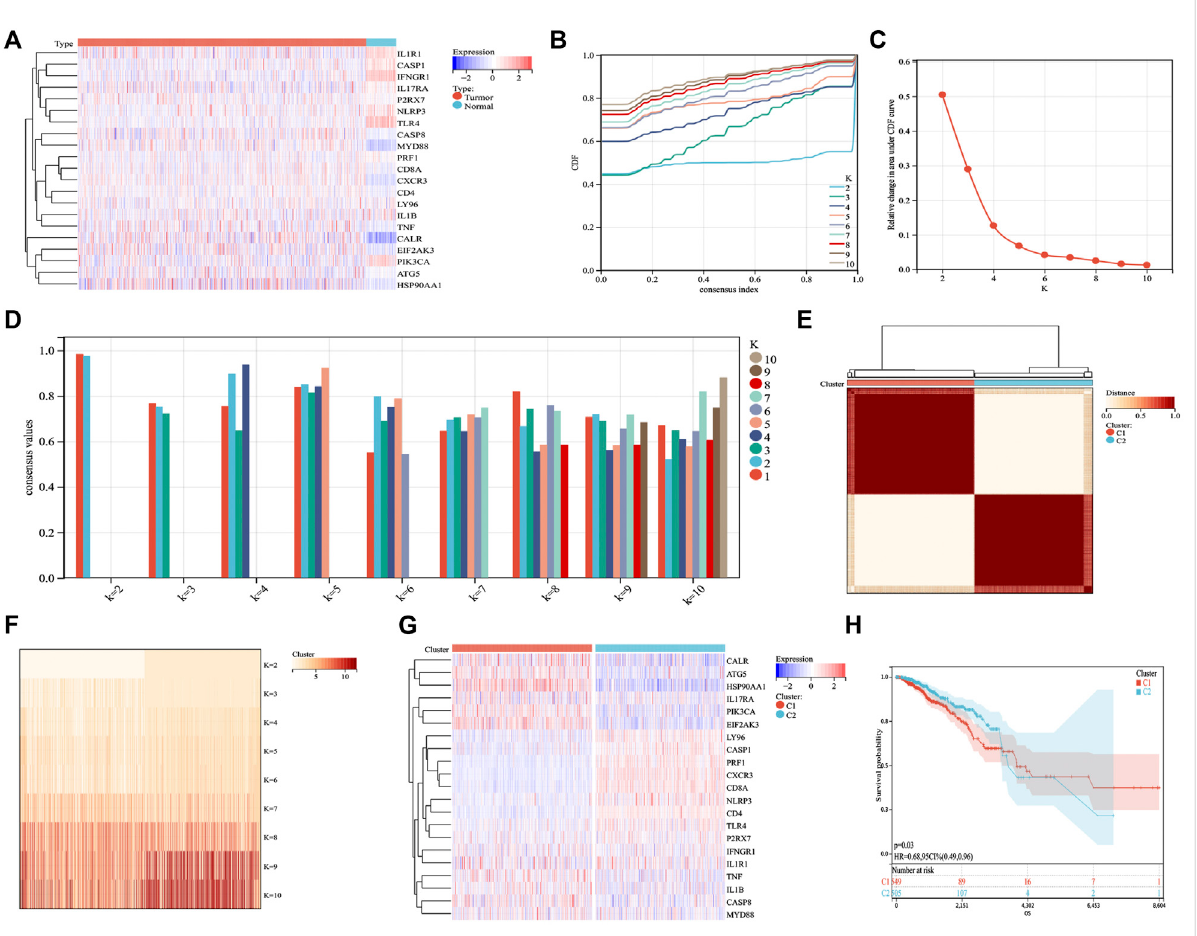
FIGURE 1 Identi fi cation of ICD subtypes by consistent clustering. (A) 21 ICD genes were expressed in BC samples, including tumor and normal samples. (B,C) Cluster analysis cumulative distribution function (CDF), indicating the area under the curve and delta decreasing trend when k = 2 – 10. (D) Sample cluster consistency diagram, showing that when k = 2, consensus values are best. (E,F) Heatmap depicting the best scheme for consensus clustering ( k = 2) for 21 genes in 1,098 BC samples. (G) Heatmap of the expression of 21 ICD genes in two subtypes. Red represents high expression; blue represents low expression. (H) Kaplan – Meier curves of the overall survival in two subtypes; the C2 group had better prognostic outcomes than the C1 group. p =